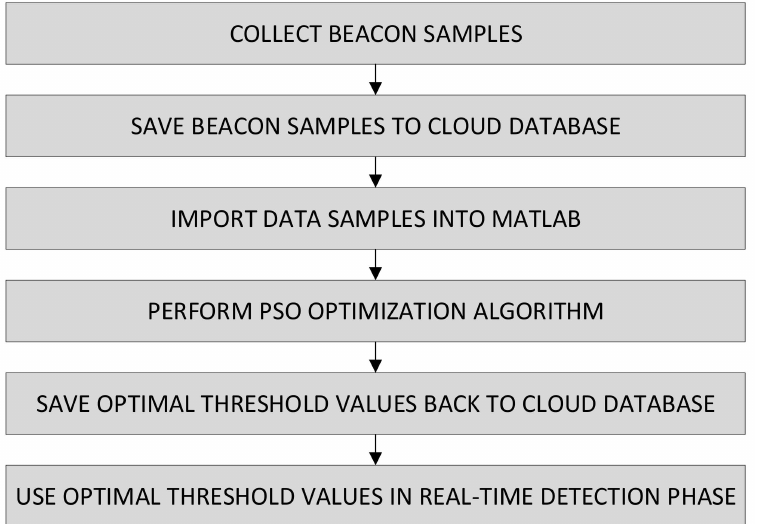
Figure 4. Calibration